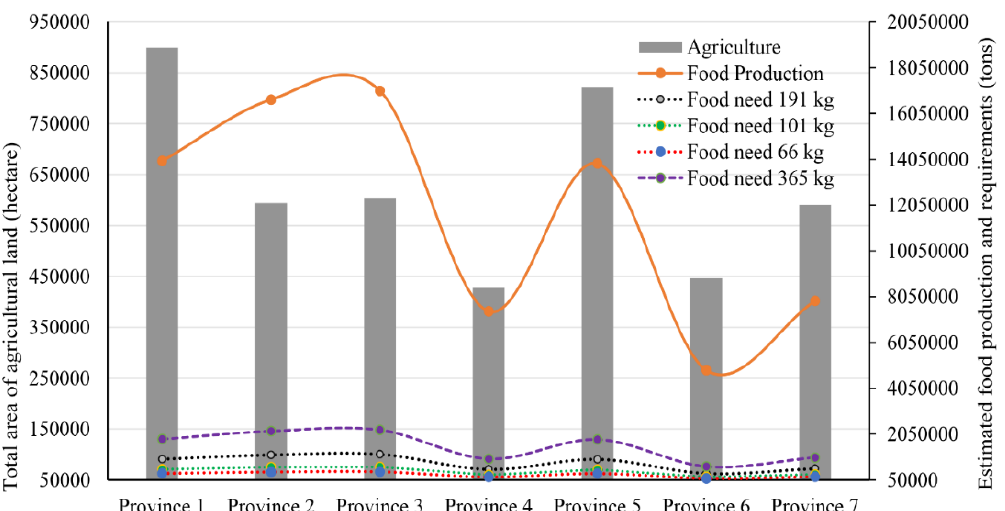
Figure 20. Agricultural areas, possible production, and grains requirements for the existing population. (Source: [44]).